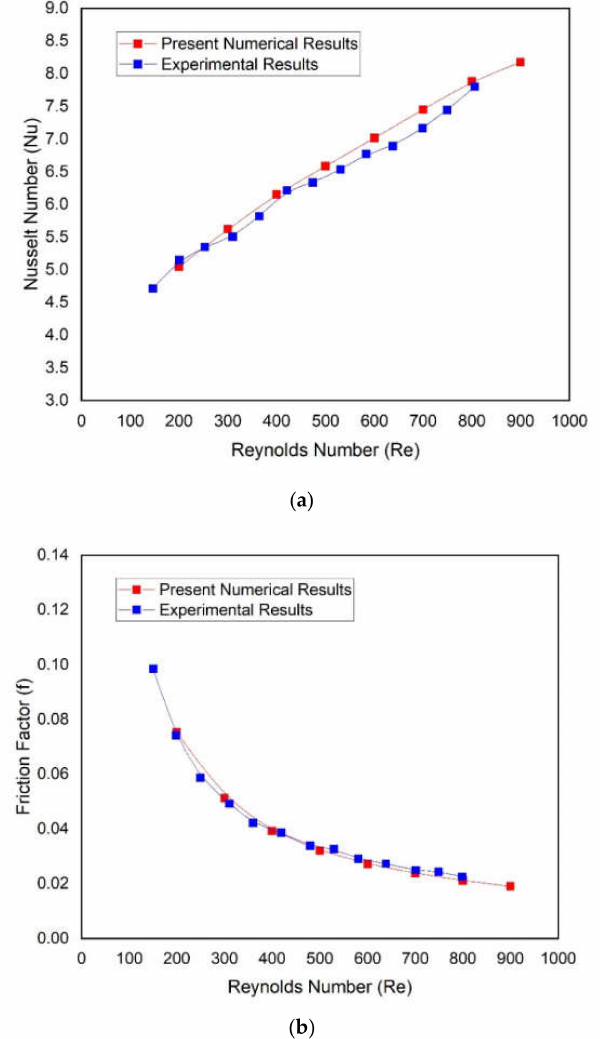
Figure 4. Comparison of present numerical results of ( a ) Nusselt number and ( b ) friction factor, with corresponding experimental results presented by Chai et al.